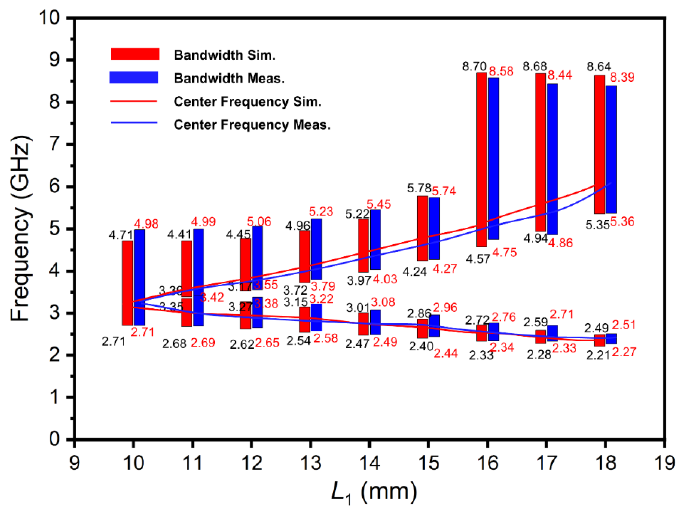
Figure 5. The bandwidth and center frequency of the antenna (the initial condition: L 1 = L 2 = 10 mm).